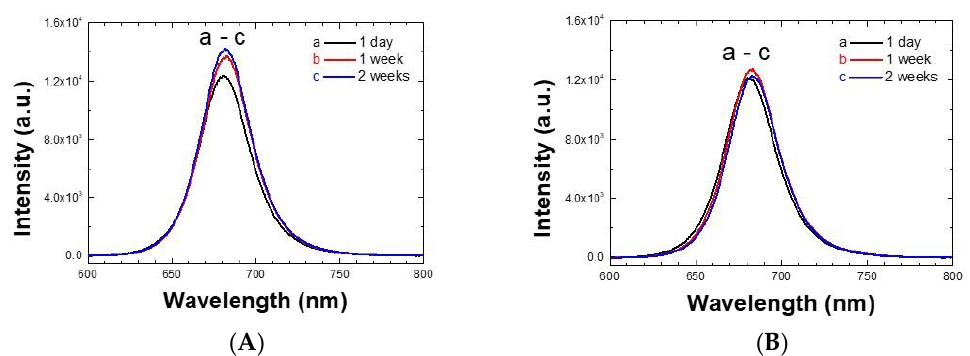
Figure 3. ( A ) Photoluminescence spectra obtained emission from the two kinds of CsPbI 3 PQDs by using commercial PbI 2 with 99.99% purity ( A ) or with using crystallized PbI 2 through hydrothermal ( B ). Three emission spectra were obtained on the day when PQDs colloidal dispersed solutions were made (a, black line), one week (b, red line), and two weeks (c, blue line) after the synthesis. The solutions were preserved under N 2 gas at 2 °C.